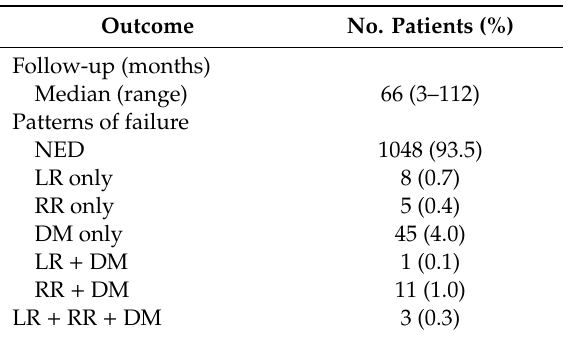
Table 2. Patterns of failure.